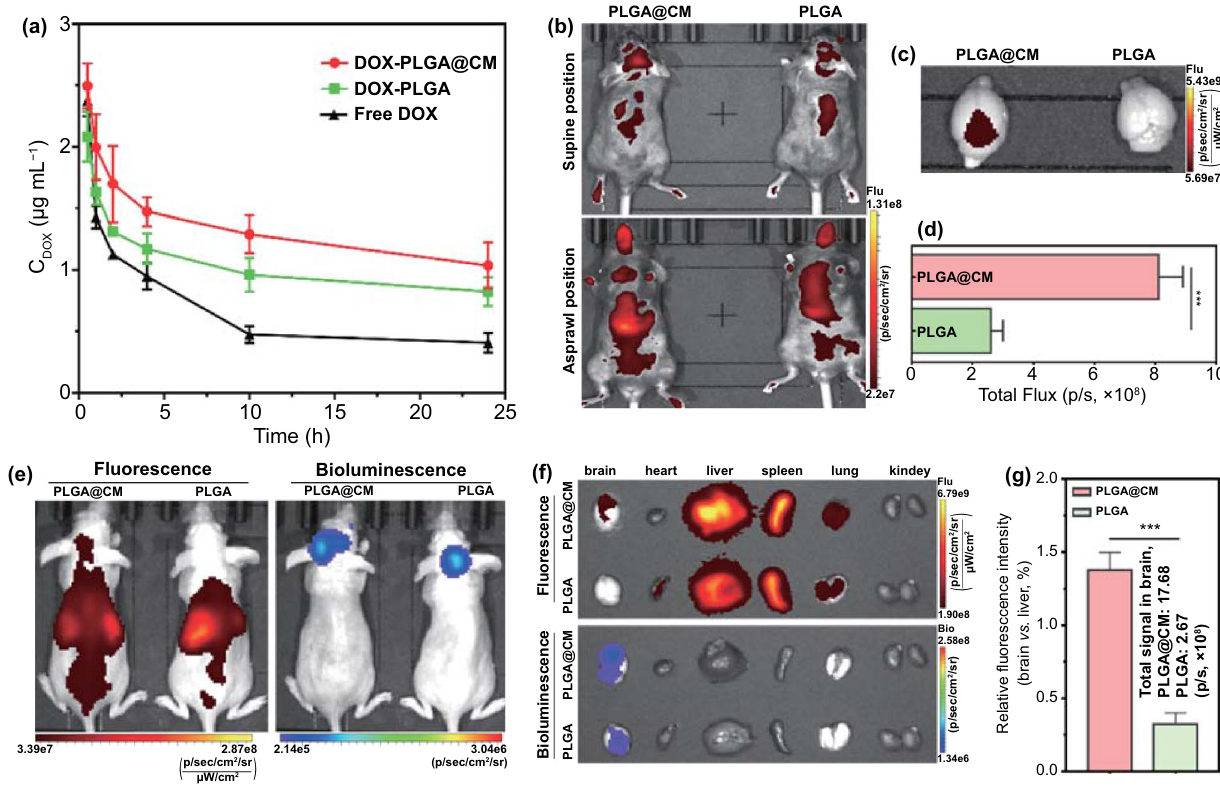
Fig. 4 Pharmacokinetics and in vivo distribution of DOX‑PLGA@CM. a Pharmacokinetics of DOX‑PLGA, DOX‑PLGA@CM and Free DOX in normal C57BL/6 J mice. b Representative in vivo fluorescence imaging of DIR labeled nanoparticles in C57BL/6L mice 3 h after injection. c Ex vivo fluorescence imaging of DIR labeled nanoparticles in the brain of C57BL/6 J mice 3 h after injection and its corresponding quantified fluorescence intensity in the brain d . e In vivo distribution of DOX‑PLGA@CM in brain metastases of breast cancer mouse model. Images were taken 3 h after the i.v. injection of DIR labeled nanoparticles. f Ex vivo fluorescence images and bioluminescence images for the treatment in ( e ). The quantitative fluorescence intensity in the brain g for the treatment in ( f ). Data represent mean ± s.d. for n = 3. *** p <